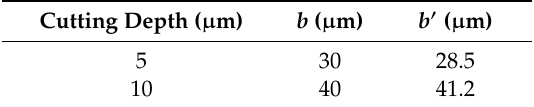
Table 2. Undeformed chip width and chip width of the V-shaped section shape.